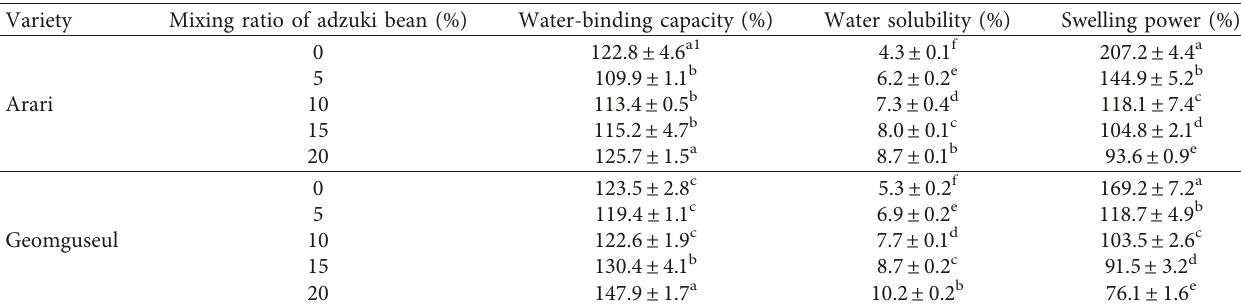
Table 2: Water-binding capacities, water solubility, and swelling power with different mixing ratios of adzuki bean. Variety